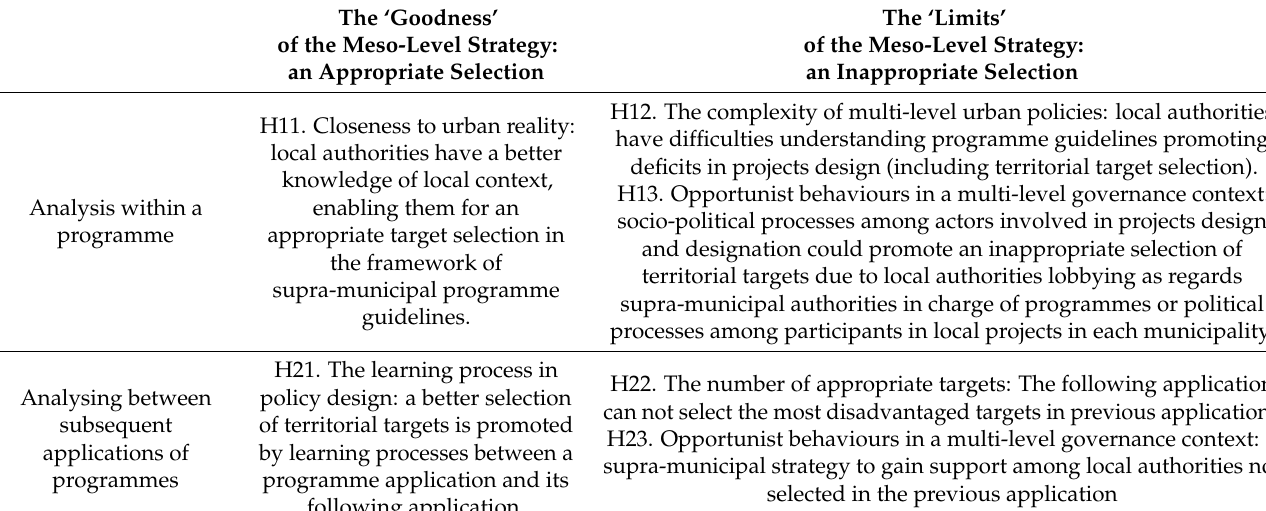
Table 1. Evaluating target selection in multi-level urban policies: the ‘goodness’ and ‘limits’ of the meso-level strategy. The